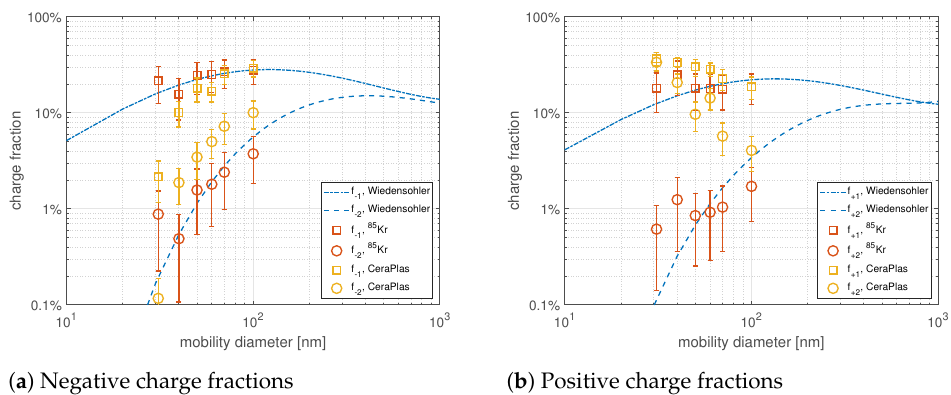
Figure 5. Fractions of single and double charged particles plotted against the mobility diameter. Dashed lines show the calculated fractions according to the Wiedensohler approximation (A6), red symbols are the measured fractions generated by the commercial 85 Kr neutralizer, and yellow symbols represent measurements with the CeraPlas ® as a charging